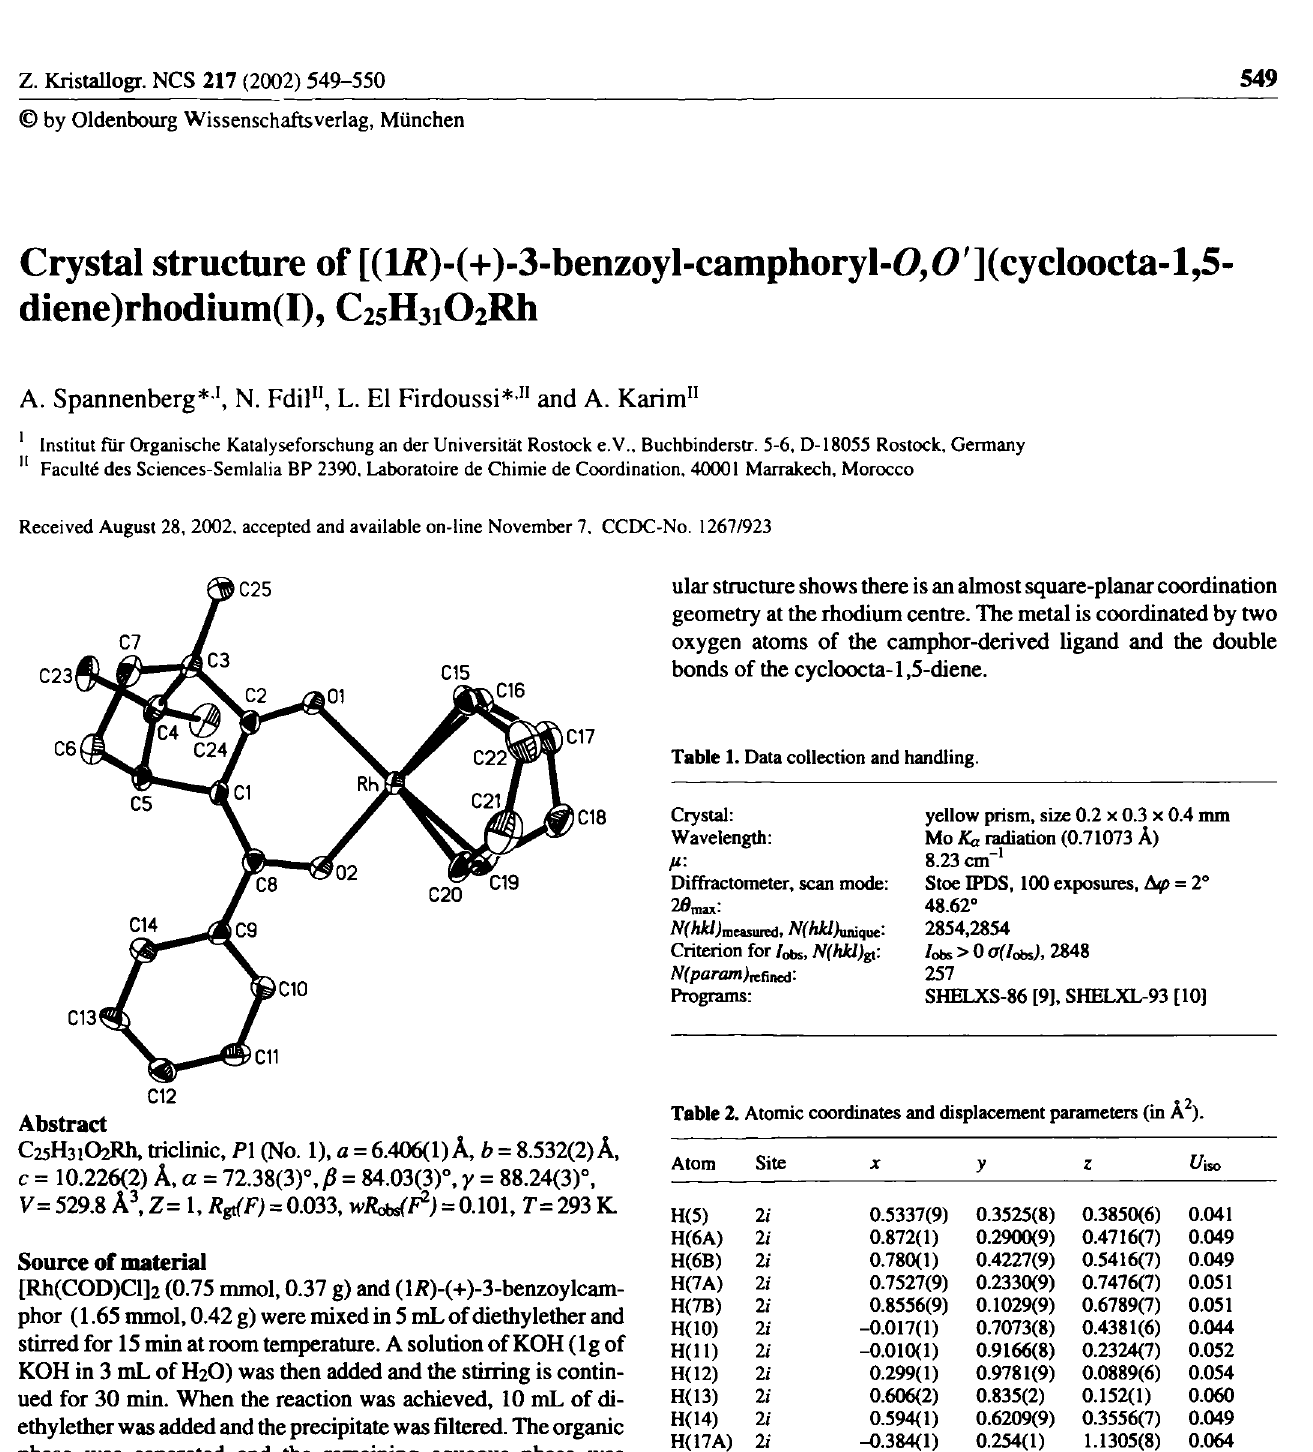
Table 2. Atomic coordinates and displacement parameters (in A 2